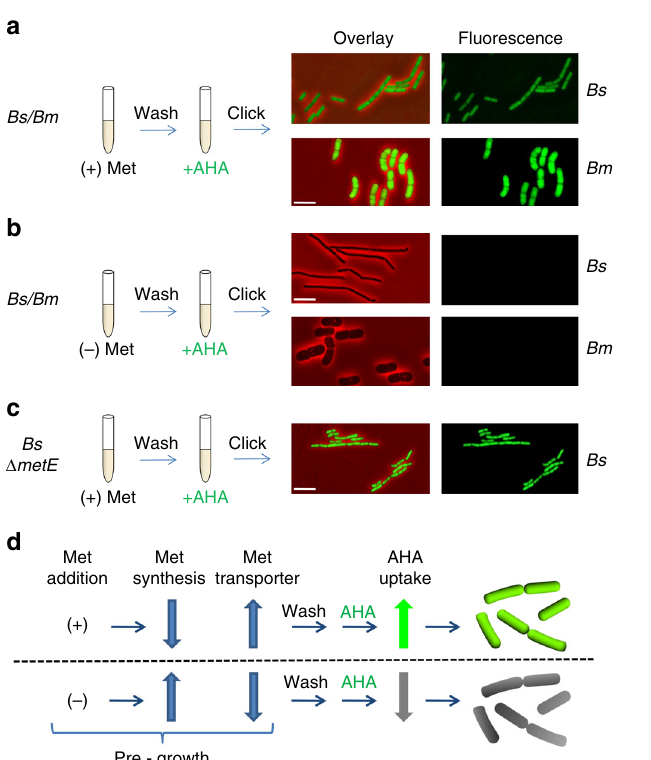
Fig. 4 Pre-incubation with Met affects AHA uptake. a , b Bs (PY79) or Bm (OS2) were grown over night in S7 medium in the presence ( a ) or the absence ( b ) of Met (50 μ g/ml). Cells were then washed in PBS×1 and resuspended in S7 supplemented with AHA (1 mM). Cells were incubated for additional 2 h, underwent click reaction and visualized by fl uorescence microscopy. Shown are overlay images of fl uorescence from AHA ( green ) and phase contrast ( red ; left panels ), and AHA fl uorescence alone ( right panels ). c Met auxotroph Bs (LS5: Δ metE ) was grown over night with Met and processed as described in a . d A schematic model of exogenous Met effect on Bacilli Met transporters and endogenous Met synthesis. Pre growth in the presence of external Met results in AHA uptake, whereas pre-growth in the absence of external Met restricts AHA uptake. Fluorescence images were normalized to the same intensity range for each strain. Scale bars represent 3 µ m